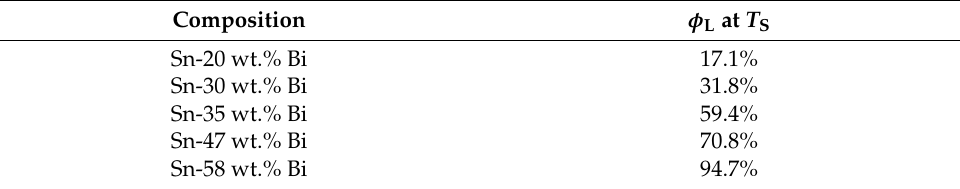
Table 3. Liquid fraction at solidus temperature over solder composition.